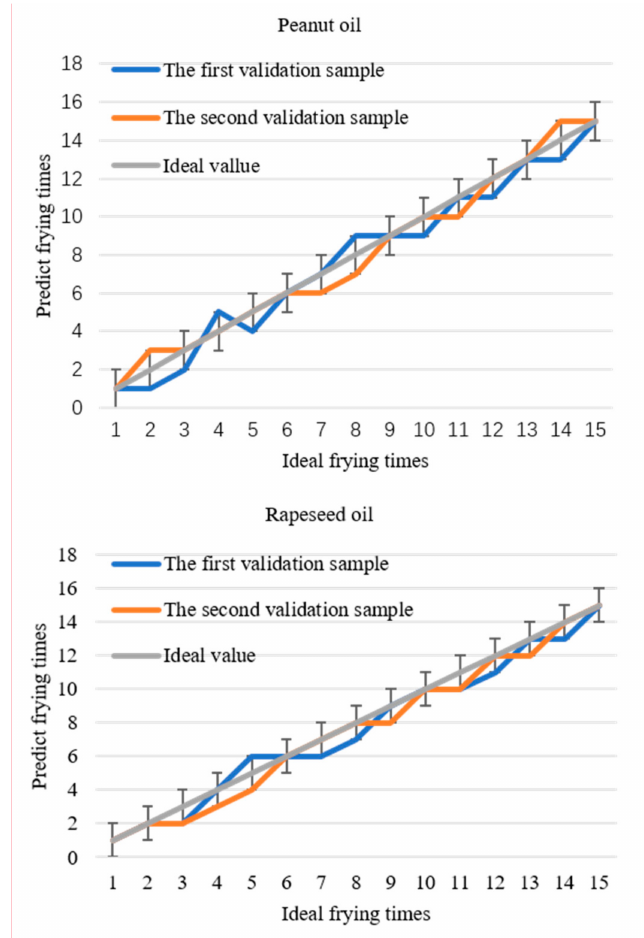
Figure 7. The relationship between the predicted frying times of the three frying oils and the actual frying